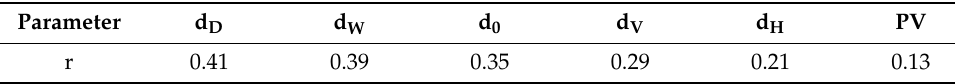
Table 1. Correlation between each of the six parameters and in situ SM